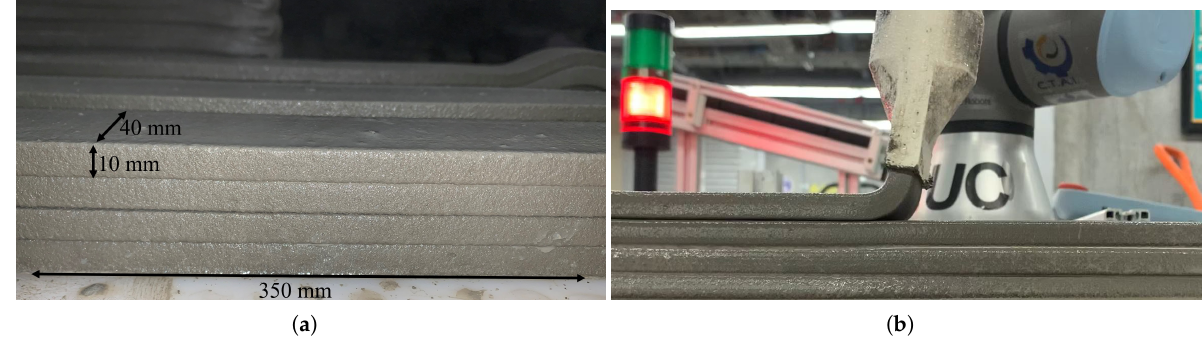
Figure 6. ( a ) 3D printed filaments for mechanical tests. ( b ) UHPC being